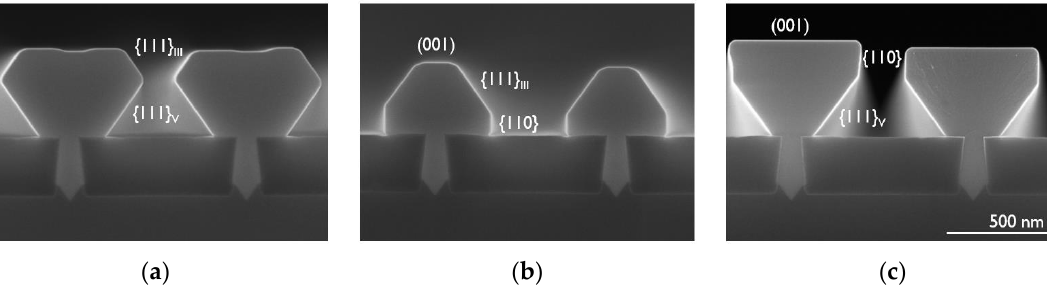
Figure 9. ( a – c ) Cross-section SEM images of GaSb NR grown under different MOVPE conditions. The facets with the fastest growth rate vanish quickly whereas the NR shape is defined by the planes with the lowest deposition rate.